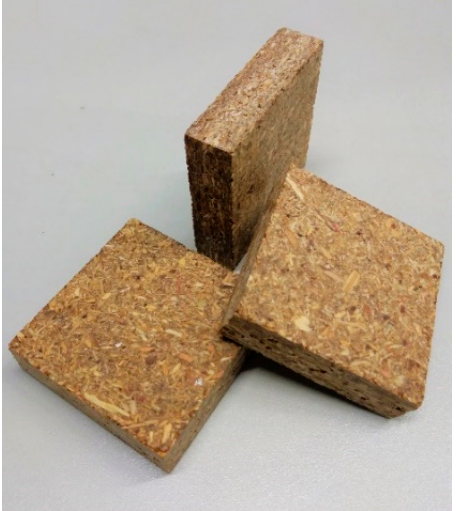
Figure 10. PB samples (5 cm × 5 cm) manufactured with 13.2% binder solids relative to the dry wood particles and pressed at 190 °C for 10 min.